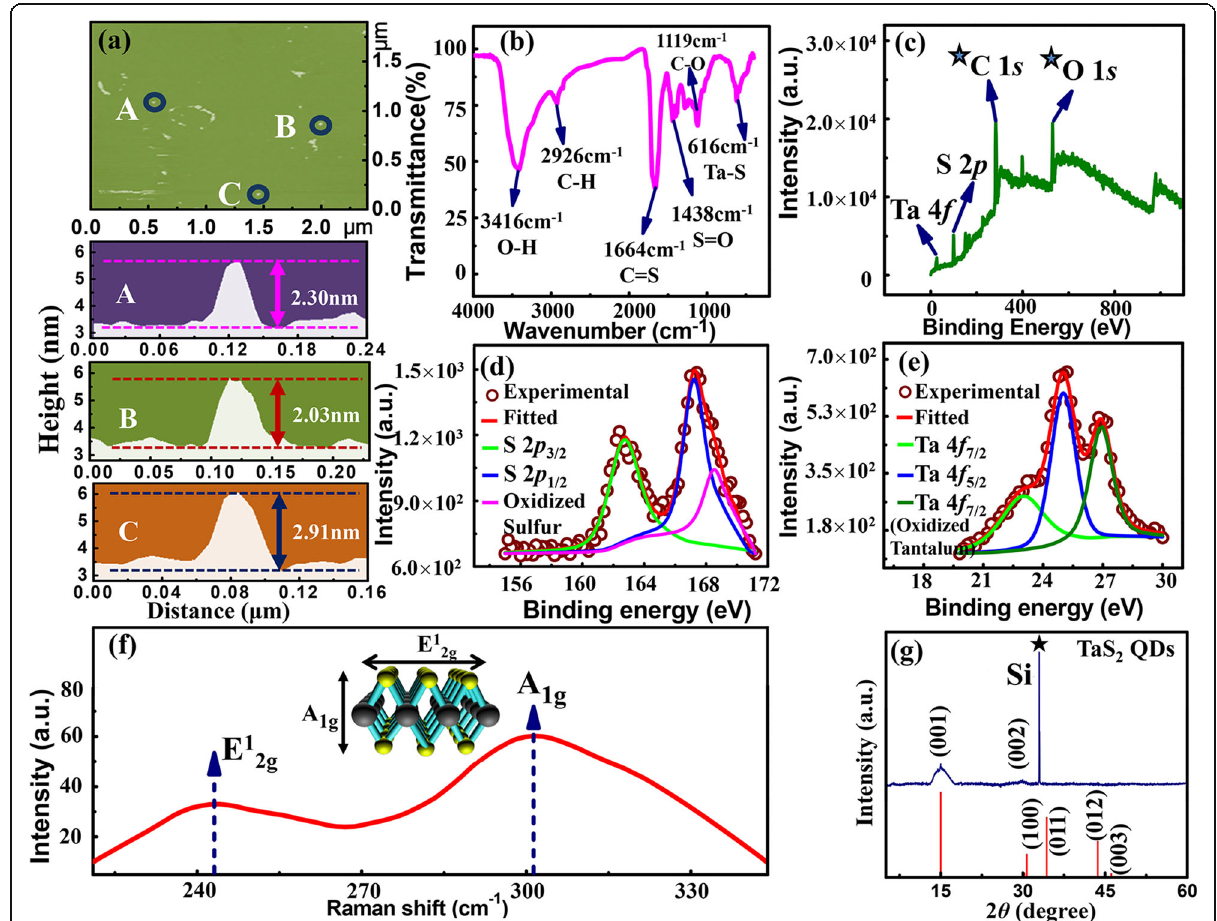
Fig. 2 a AFM morphology and height analysis results of TaS 2 QDs, labeled A, B and C, were randomly selected three points; b TaS 2 QDs FTIR spectrum; c the full-scan XPS spectrum of the TaS 2 QDs; d XPS spectrum of S 2 p ; e XPS spectrum of Ta 4 f ; f The Raman vibration mode of TaS 2 QDs and Raman spectra of TaS 2 QDs; g XRD diffraction pattern of TaS 2